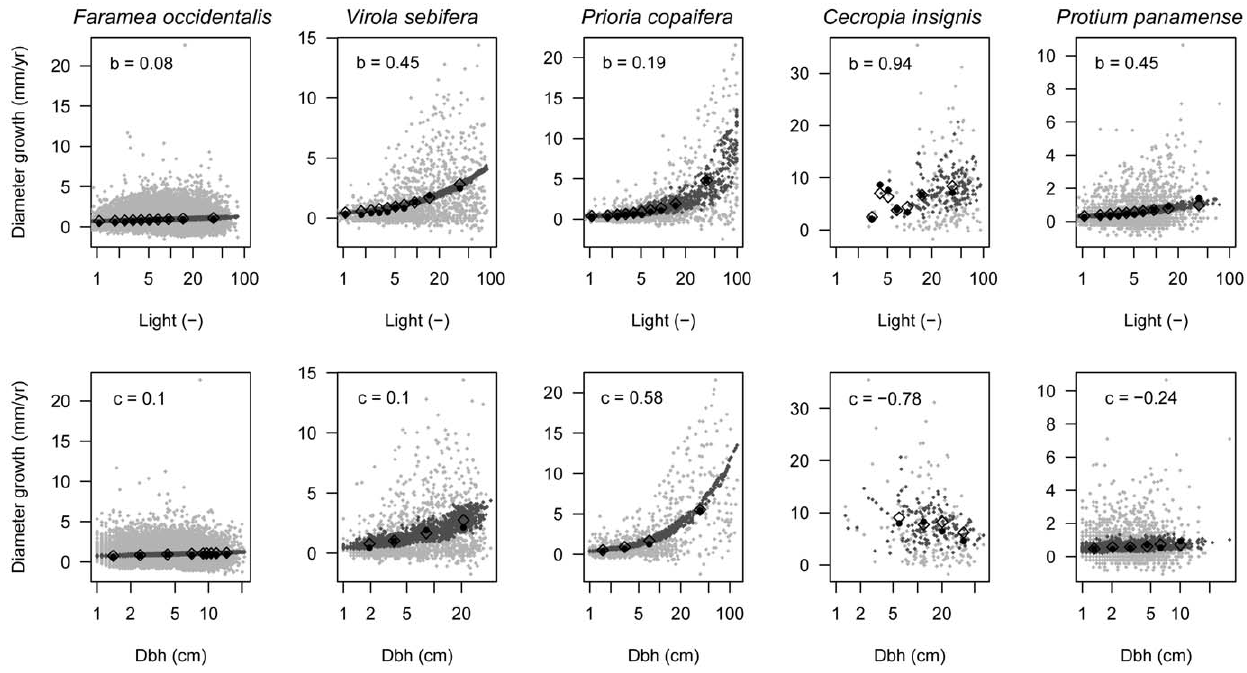
Figure 4. Observed and predicted growth rates against light availability and stem size. Light ( b ) and dbh dependence ( c ) of growth rates for five species in the census interval 1990–1995. Observed (dark grey) and predicted (light grey) growth rates of individuals, mean observed (filled circles) and predicted (diamonds) growth in different light and dbh classes. Species’ parameters are given in the panels. Species are Faramea occidentalis (N=20 110), Virola sebifera (N=1469), Prioria copaifera (N=979), Cecropia insignis (N=164) and Protium panamense (N=2227).